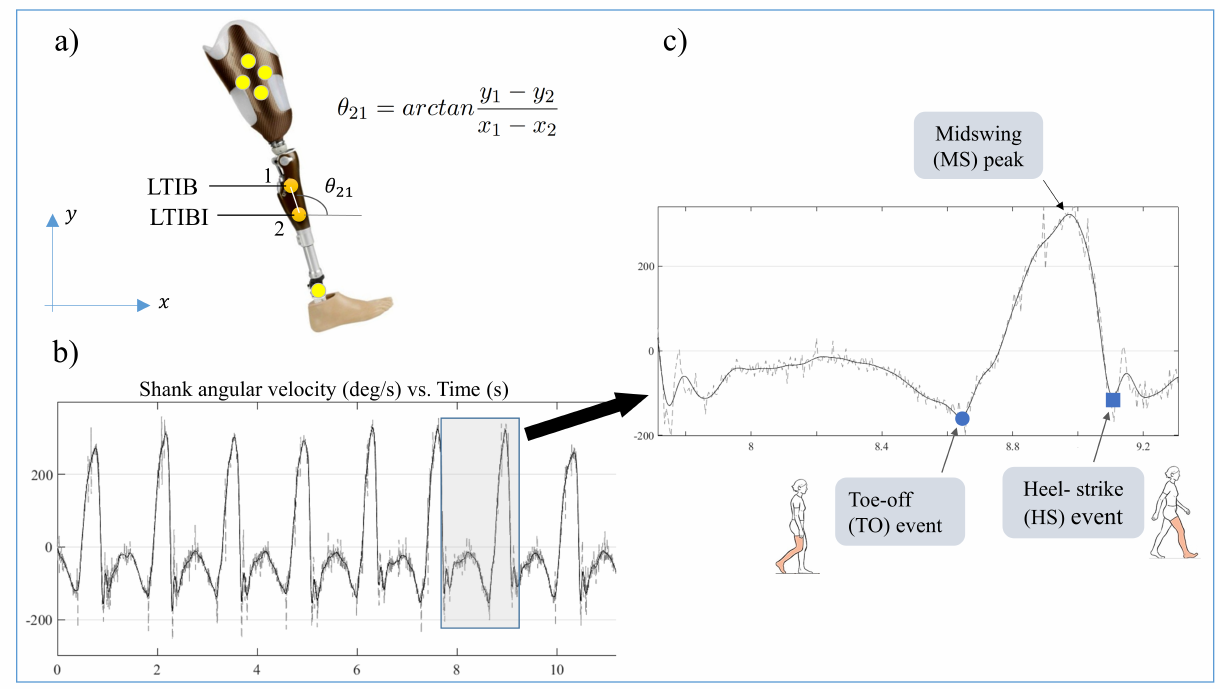
Figure 1. ( a ): Placement of tibia markers for leg orientation and velocity calculation; ( b ) A typical shank velocity signal with raw (grey) and filtered (black) data; ( c ) Enlarged view of one gait cycle from the velocity signal. The algorithm starts with the detection of the largest positive peaks in the signal (marked as MS) which define the intervals for gait events. TO is identified as the last negative peak (or minima) just before the MS (circle) while HS is defined as the negative peak just after the MS